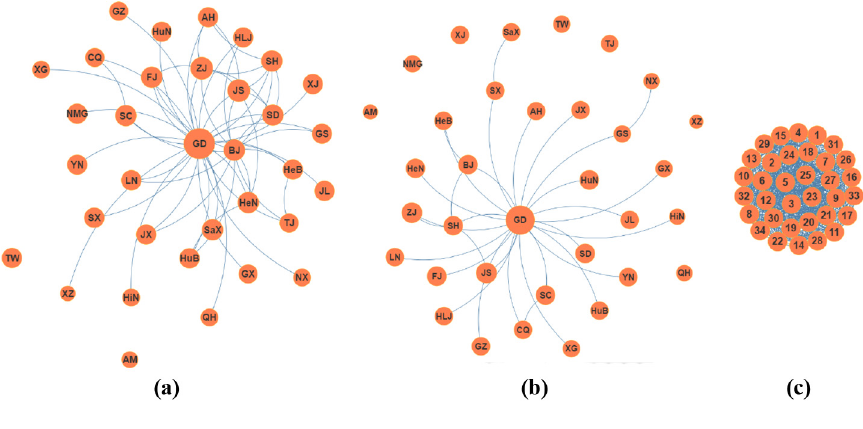
representations of message diffusion inside and across provinces in WM data